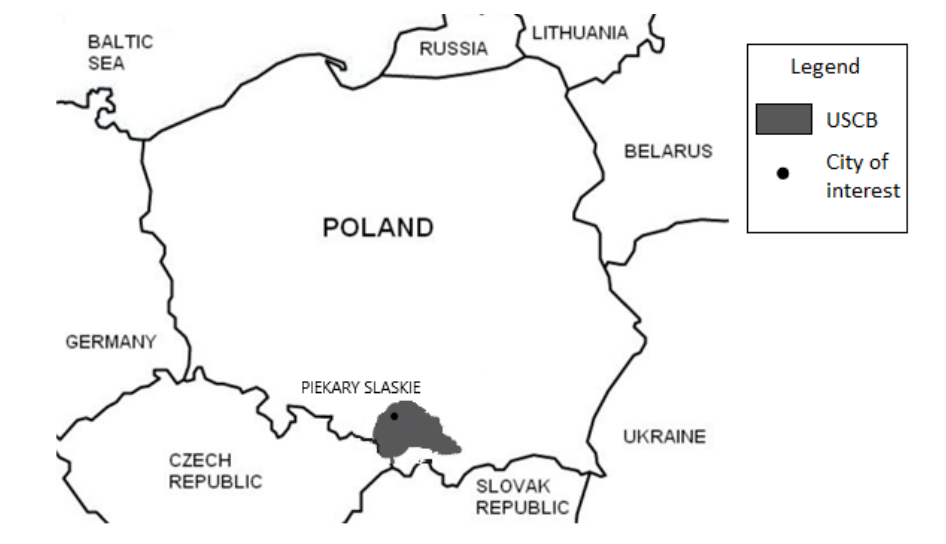
Figure 1. Location of the area of investigation.